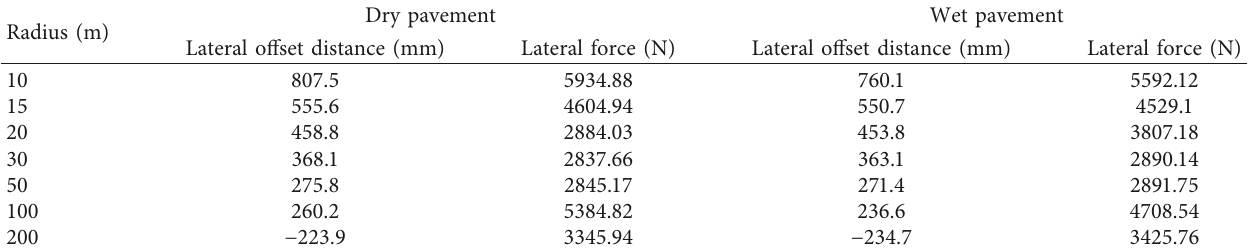
Table 4: Tire maximum lateral distance and lateral force with different curve radius.